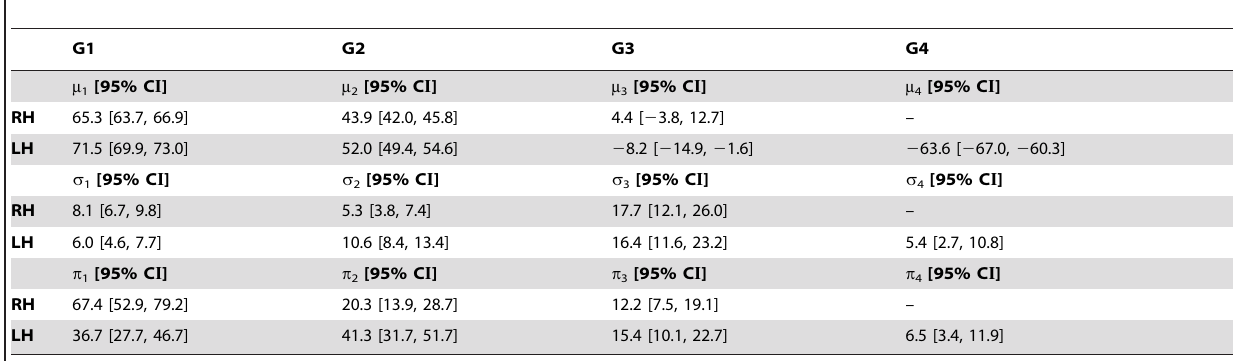
Table 4. Comparison of HFLI optimal Gaussian mixture function model parameters for the RH and LH samples.